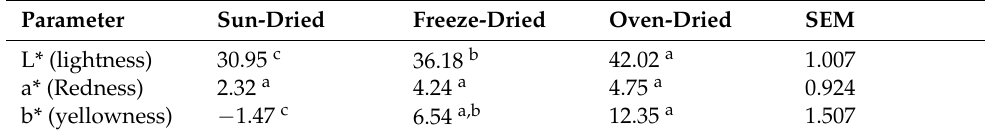
Table 2. Color values of oven-dried, sun-dried and freeze-dried mealworm larvae.